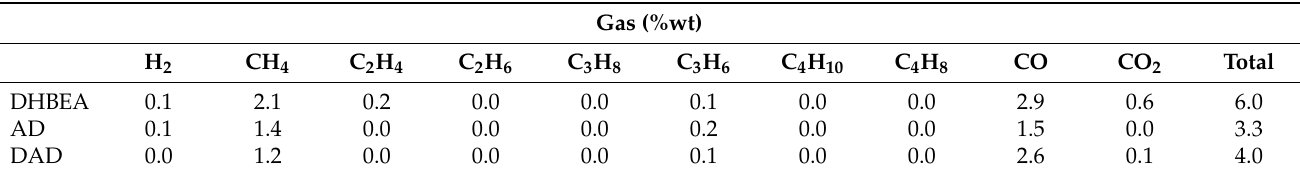
Table 5. Yields of gases by percentage of DX obtained by catalytic cracking of 30% DX in n-hexane on beta zeolite, beta catalyst hydrothermally treated at 720 ◦ C, and fresh beta catalyst, 500 mg of catalyst at 500 ◦ C of reaction.